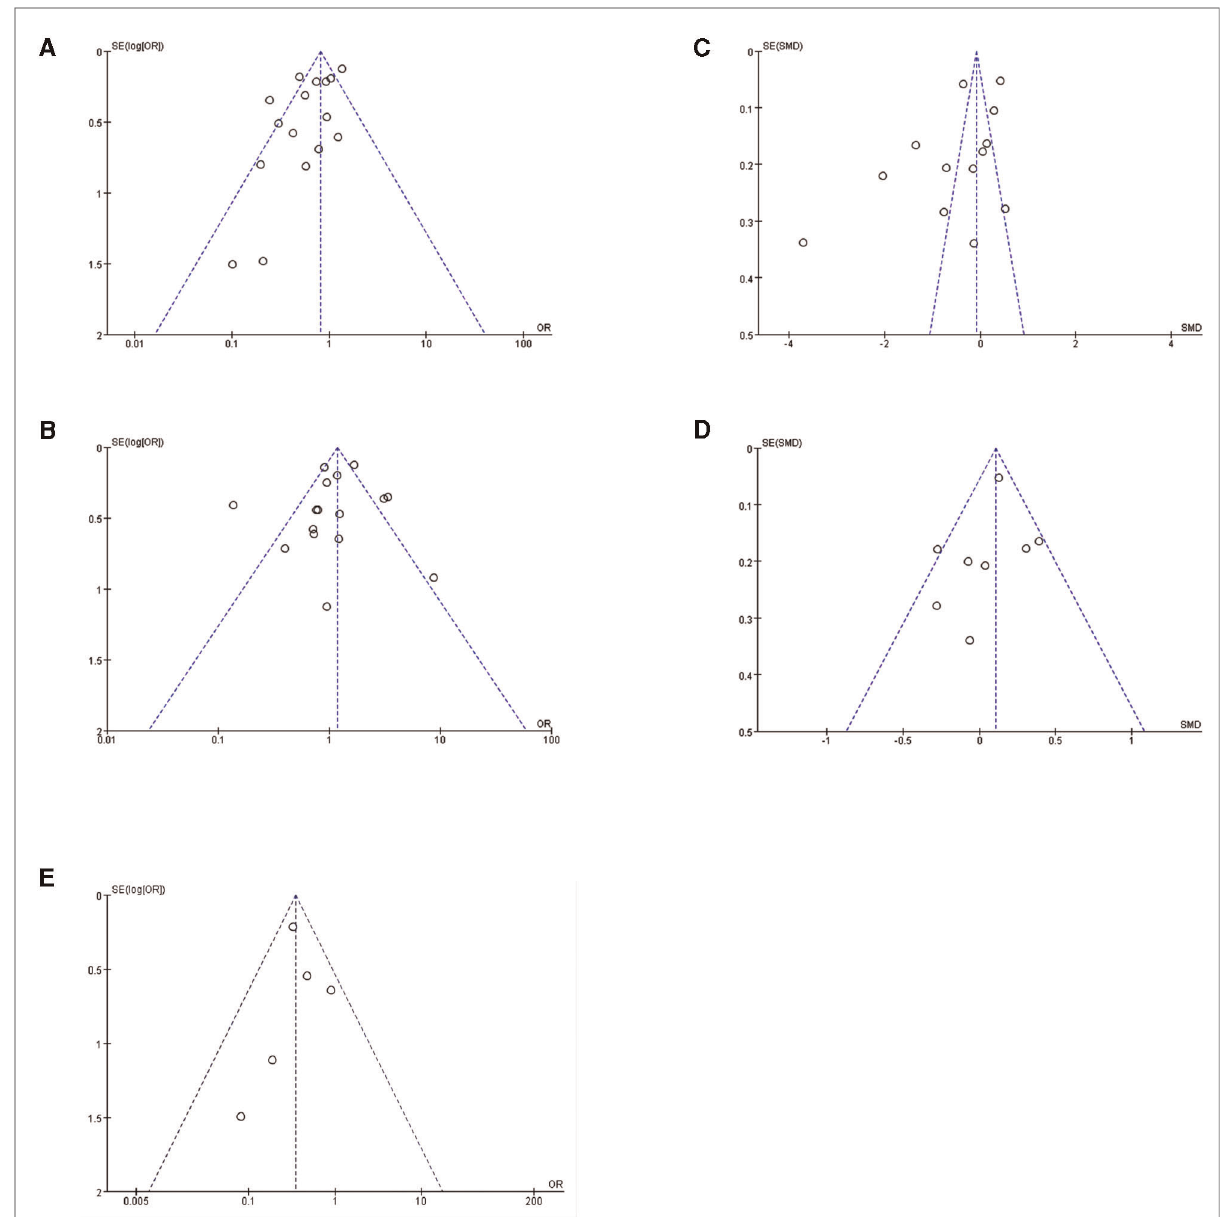
FIGURE 4 Funnel plots of meta-analysis. ( A ) Funnel plot for stone clearance comparison. ( B ) Funnel plot for complication comparison. ( C ) Funnel plot for operation time comparison. ( D ) Funnel plot for hospital stay comparison. ( E ) Funnel plot for additional puncture